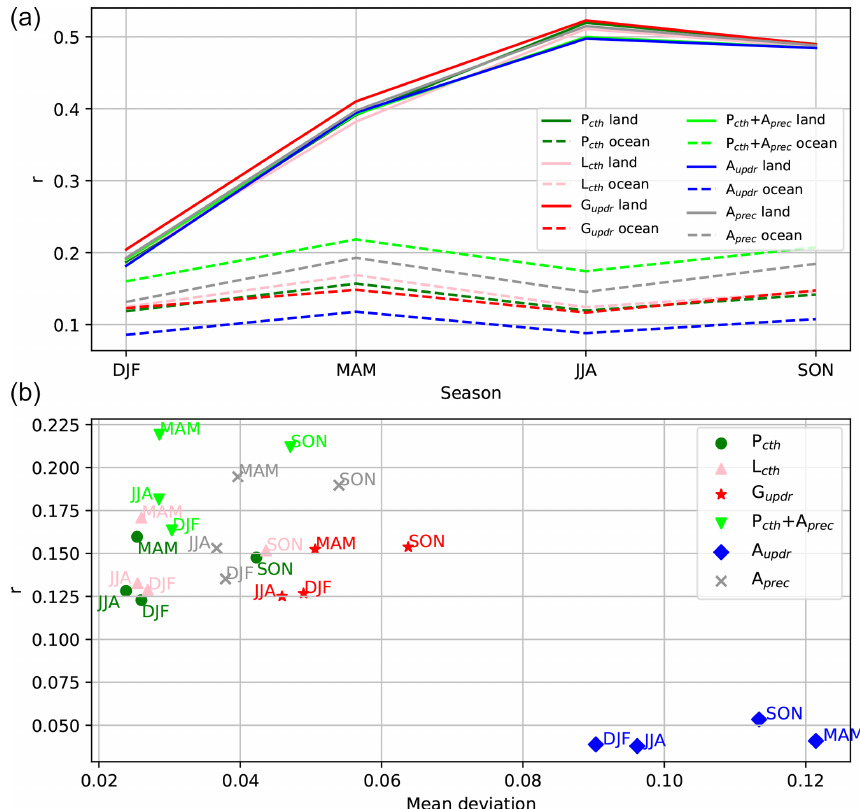
Figure 13. Seasonal evolution of the spatial correlation coefficient ( r ) between the observed and simulated ratio of LCC( > 9ms) lightning to total lightning for land and ocean (a) as well as the seasonal global correlation coefficient versus the deviation averaged over all the grid cells between the observed and simulated ratio of LCC( > 9ms) lightning to total lightning (b) . Each point represents a different